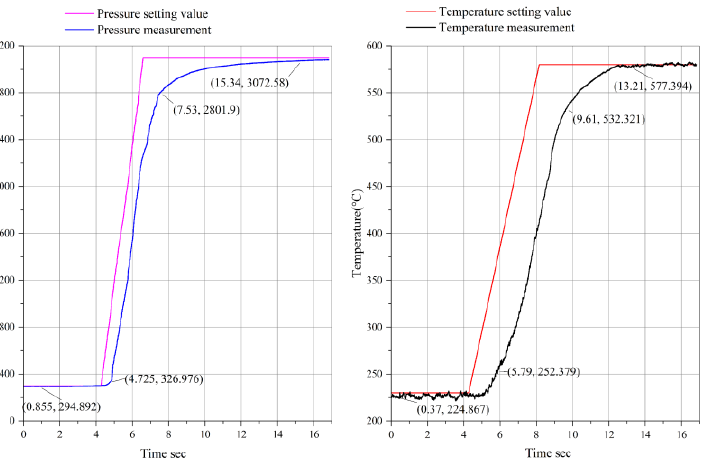
Figure 11. Compressor bleed air simulation of test piece two under the rise rates of 900 kPa/s and 90 °C/s.